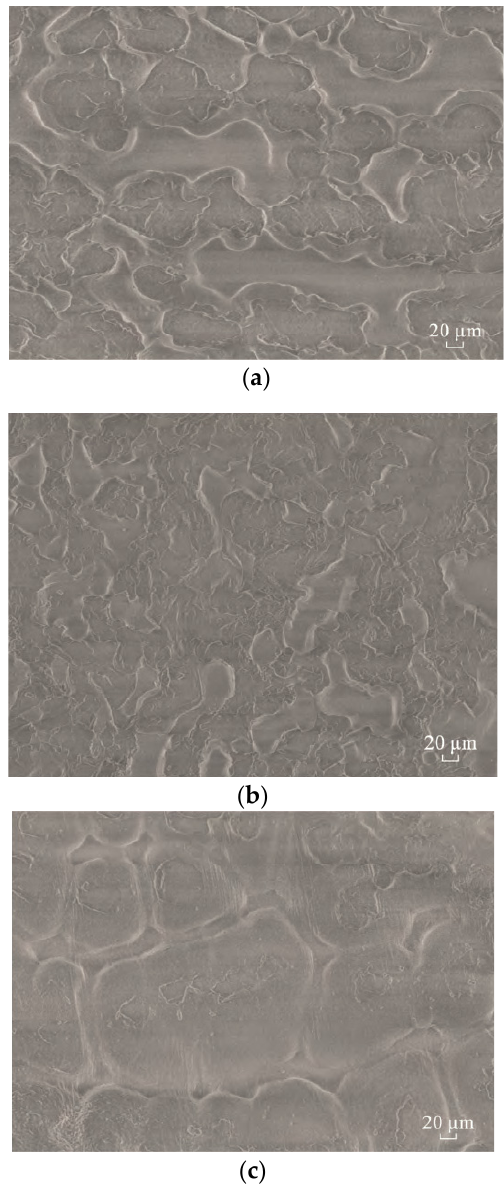
Figure 11. SEM test results of XLPE specimens aged 1440 h [55]. ( a ) Unaged samples; ( b ) single heat-aged sample; ( c ) combined heat-vibration aging sample.